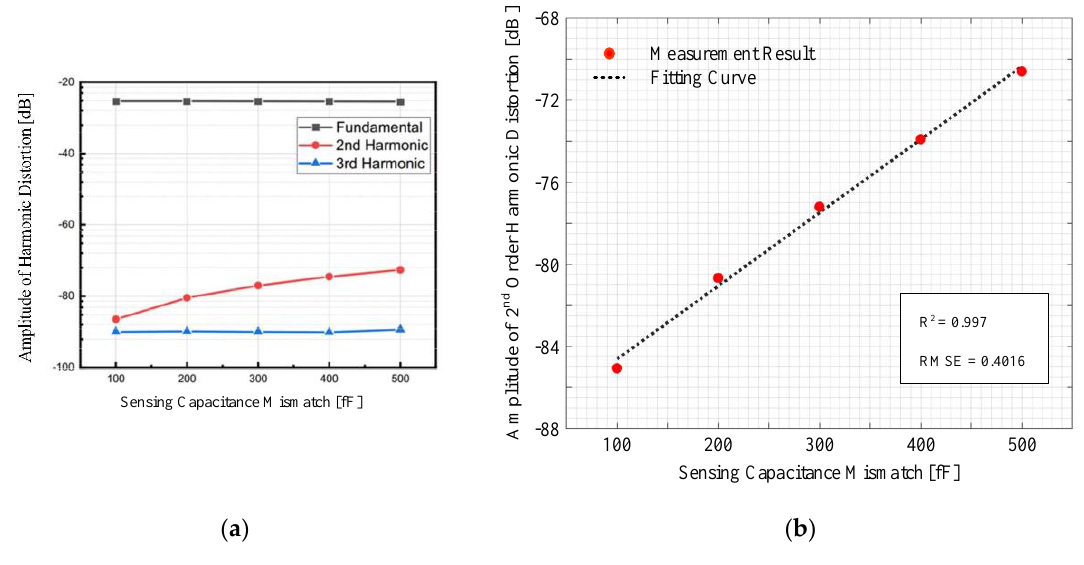
Figure 8. The harmonic distortion with respect to the mismatch in sensing capacitances. ( a ) Amplitude of harmonic distortions with different sensing capacitance mismatch. ( b ) Measurement RMSE results for the second − order harmonic distortion.